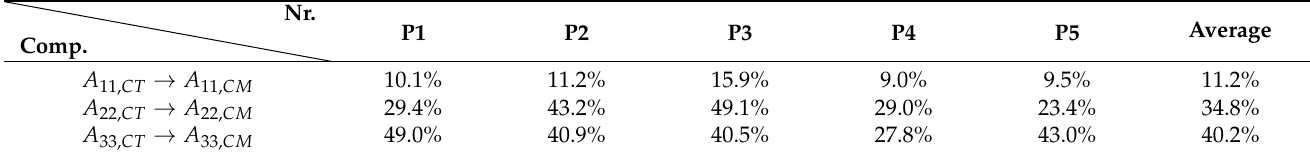
Figure 11. Experimental (CT) and simulative (CM) components of the fiber orientation tensor A ij plotted over normalized position for PPAGF50 at plate level (P1–P5) in optimized condition C NC ,2 Table 5. Relative deviation of the averaged orientation tensors from experiment 𝐴 (cid:3036)(cid:3037),(cid:3004)(cid:3021) and simula- tion 𝐴 (cid:3036)(cid:3037),(cid:3004)(cid:3014) of PPAGF50 on plate level (P1–P5) in optimized condition 𝑪 (cid:3036),(cid:3004)(cid:3014)(cid:3015)(cid:3004),(cid:2870) . Nr.